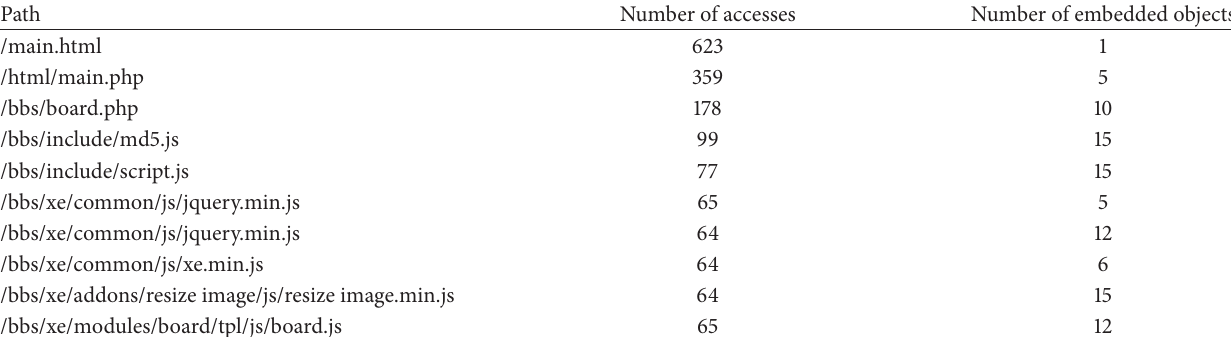
Table 3: Analysis of web objects (Gangneung-Wonju National University).